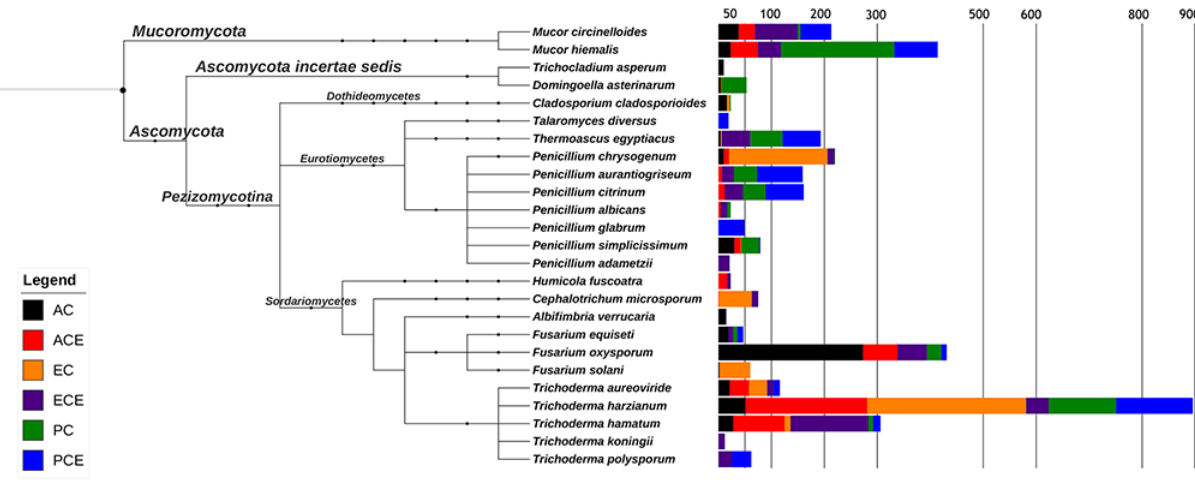
Fig. 1 Phylogenetic tree of the fungi colonizing the tomato rhizosphere, 2015–2017. AC – Antalya F 1 cv. control; ACE – Antalya F 1 cv. + C. etunicatu ; EC – Esmira F 1 cv. control; ECE – Esmira F 1 cv. + C. etunicatum ; PC – Pelikan F 1 cv. control; PCE – Pelikan F 1 cv. + C. etunicatum .